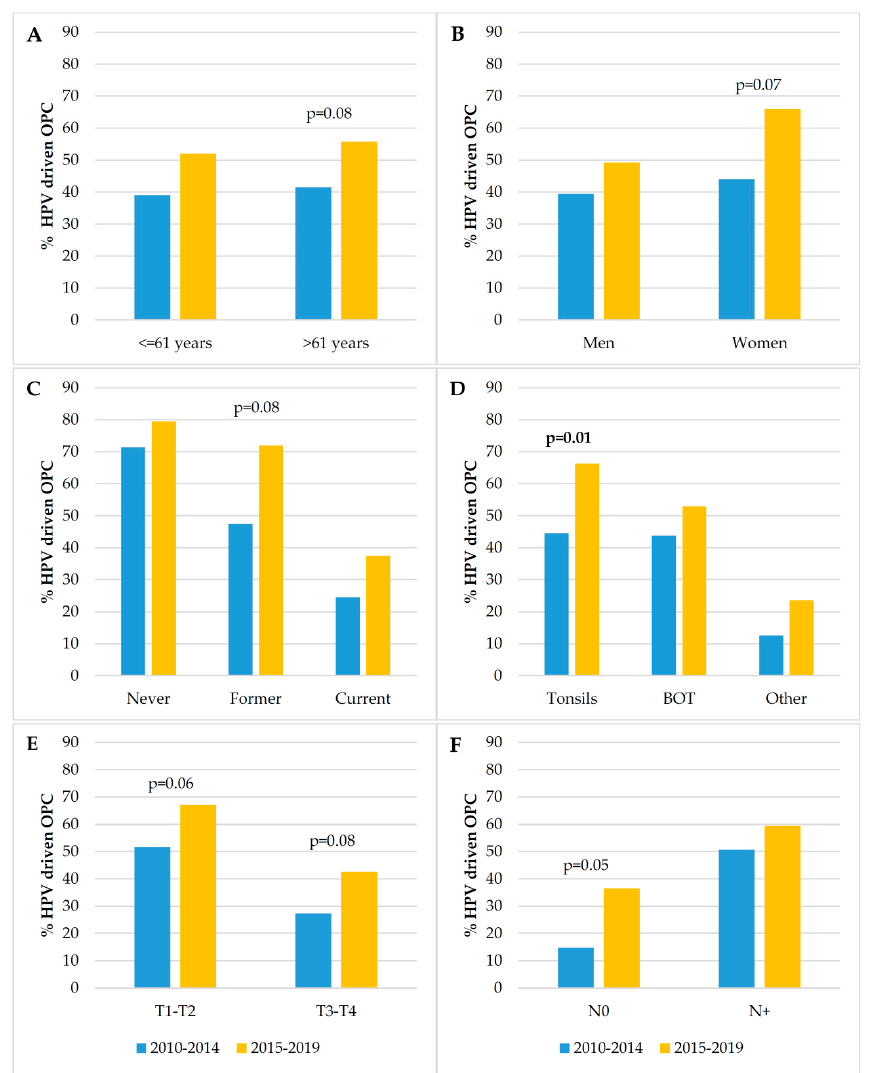
Figure 2. Prevalence of HPV-driven oropharyngeal squamous cell carcinomas (OPSCC) according to the selected variables and the two periods of diagnosis: ( A ): age at diagnosis; ( B ): sex; ( C ): smoking status; ( D ): cancer subsite (Tonsils; BOT, base of the tongue; Other, soft palate, uvula, epiglottic vallecula, amygdaloglossus sulcus, posterior wall); ( E ): T status (primary tumor category); ( F ): N status (N0, without nodal involvement; N+, with nodal involvement); p values for the comparison between periods are only shown when <0.10. Significant differences are highlighted in bold (cut-off for statistical significance was set at 0.05).